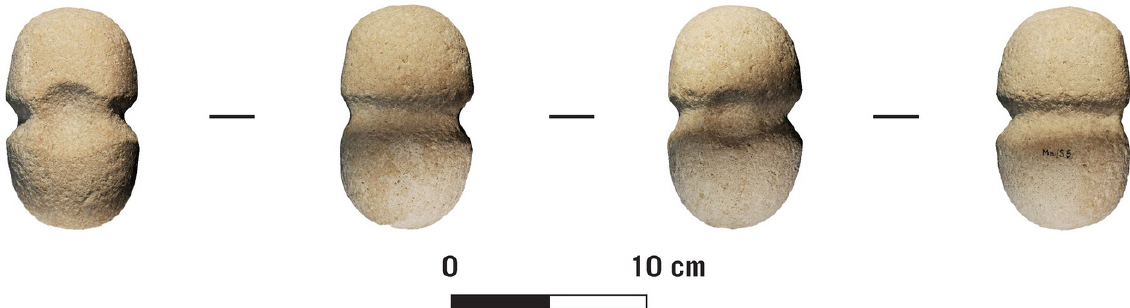
Figure 3. Lithic hammerstone ID 21136 observed in four different views. On its body appears a continuous groove for the hafting and within it two opposed drafted